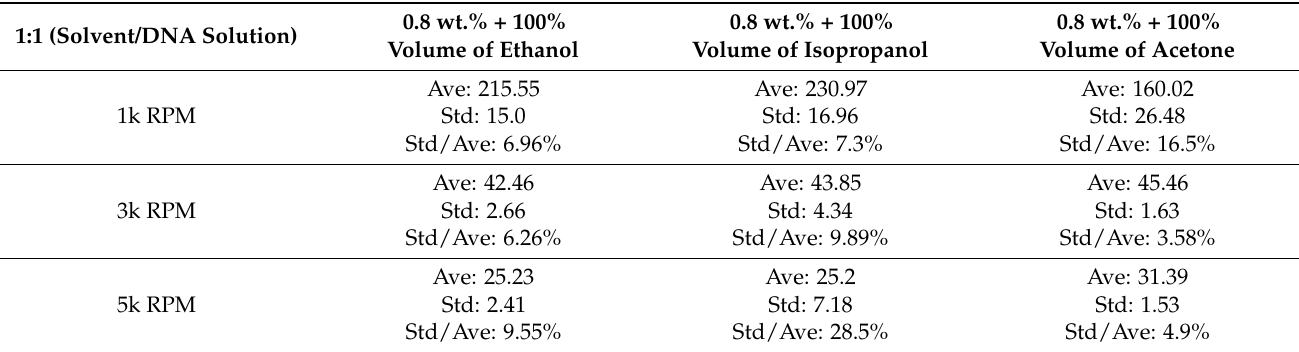
Table 5. Average thickness (nm) and standard deviation (nm) from 5 × 5 measurements of 1:1 EtOH/H 2 O, 1:1 isopropanol/H 2 O, and 1:1 acetone/H 2 O DNA solutions. A total of 2 mL of aqueous DNA at 8 mg/mL (0.8 wt.%) diluted with 2 mL of ethanol, isopropanol, or acetone